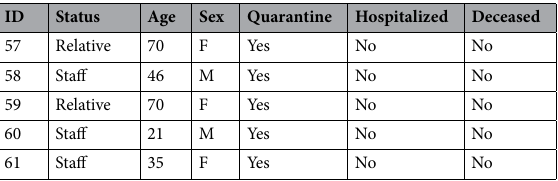
Table 1. Overview of confirmed COVID-19 cases in nursing home NH01.a. Order by the onset of symptoms.